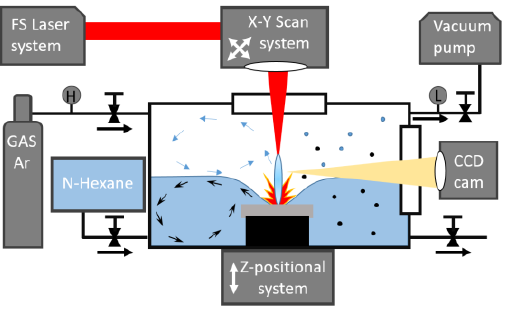
Fig. 1. Schematic representation of the surface treatment of a titanium sample in n-hexane.